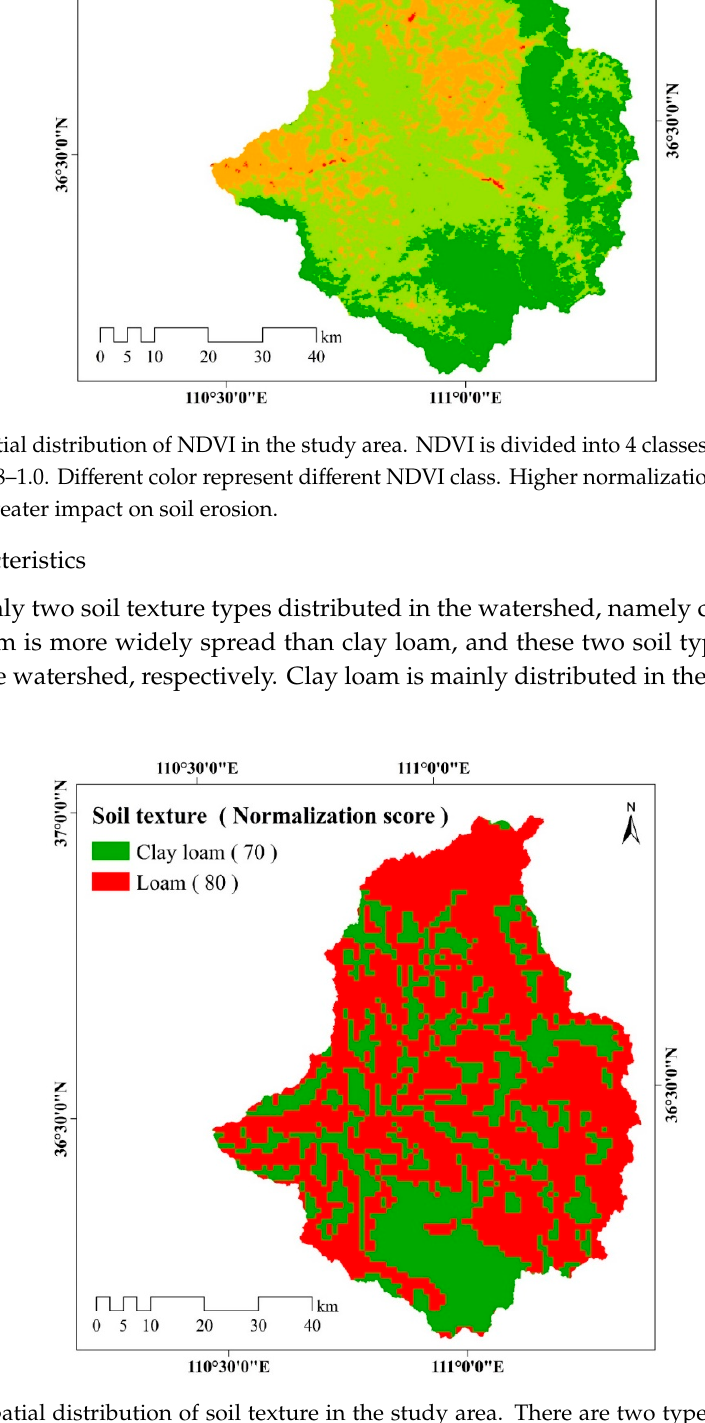
Figure 10. Spatial distribution of soil texture in the study area. There are two types of soil texture including clay loam and loam. The different colors represent the different soil texture types. A higher normalization score of soil texture represents a greater impact on soil erosion.